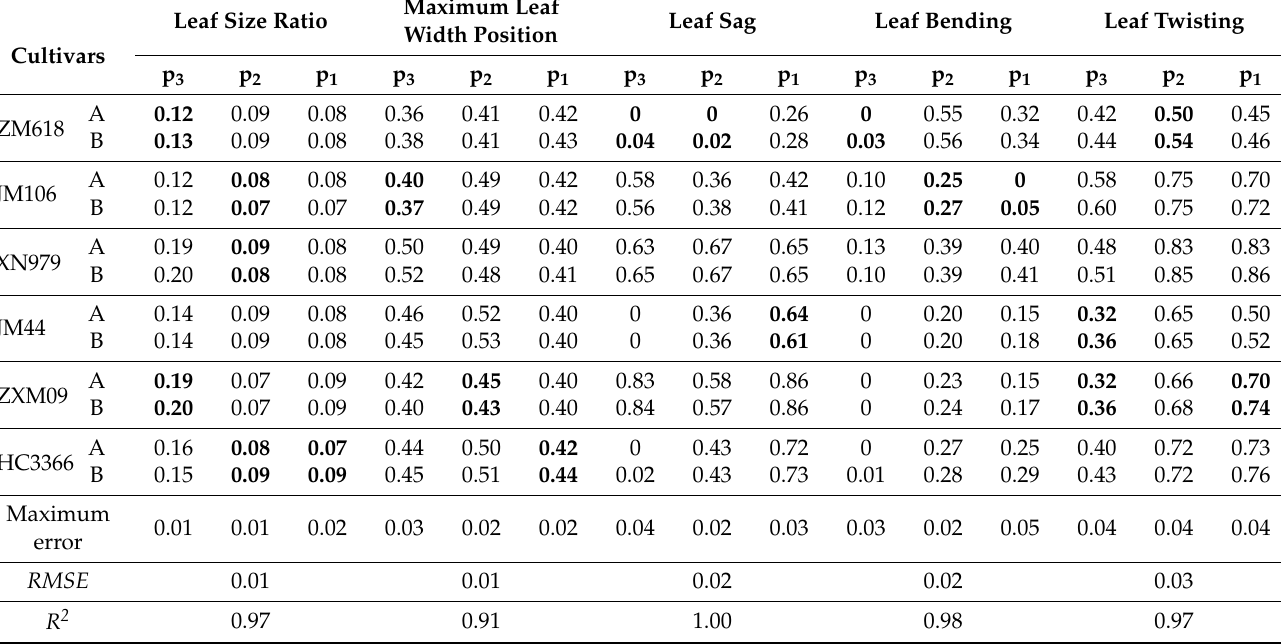
Table 4. Comparison between wheat leaf deformation results (A) and leaf shape parameters extracted from original 3D digitizing data